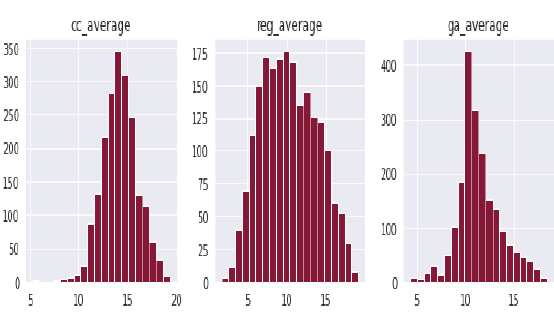
Figure 2 . Distribution of features and target